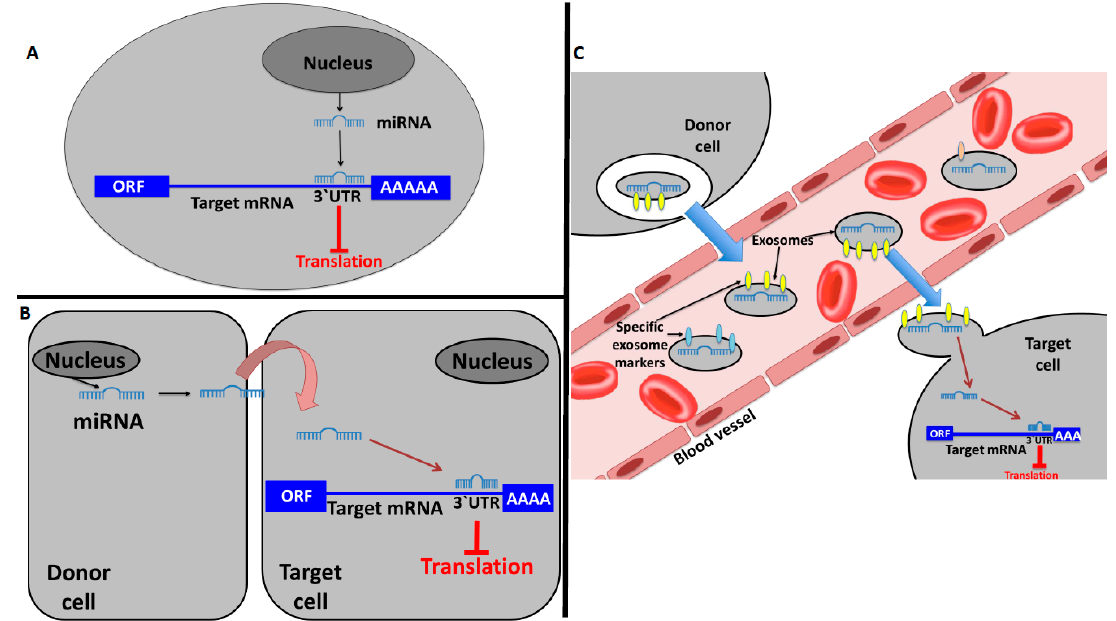
Figure 1. MicroRNAs (miRNAs) working in a hormone-like fashion. ( A ) Autocrine communication: a miRNA produced by a cell binds to autocrine receptors of the same cell inducing a local signaling. ( B ) Paracrine communication: a miRNA produced by a cell transmit a local signaling between nearby cells. ( C ) Endocrine communication: an extracellular vesicle (EV)-embedded miRNA is the mediator of distant